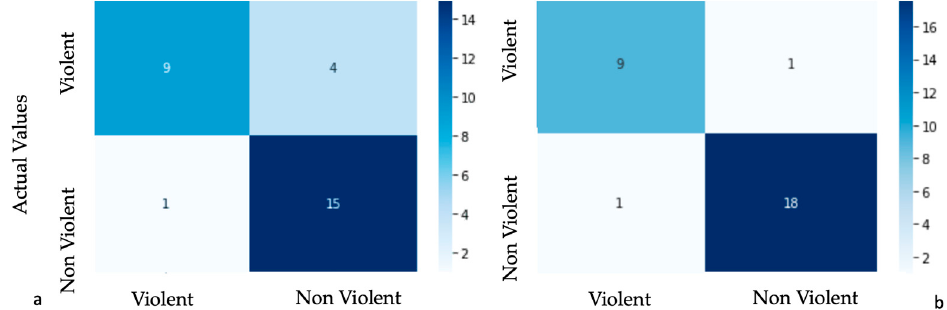
Figure 10. Visualization of the confusion matrix of the original ( a ) and extended ( b ) SVD.